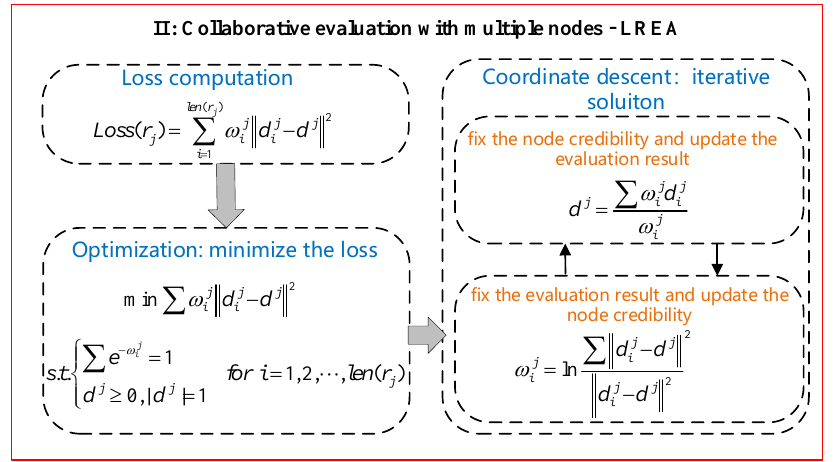
Figure 6. Collative evaluation procedure with multiple nodes.